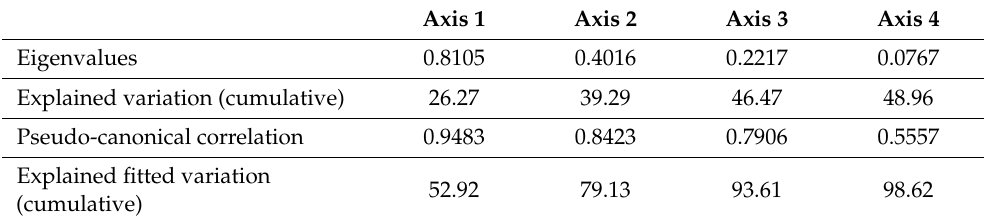
Figure 8. CCA of the physicochemical factors of the studied sites ( a ) and taxa ( b ) . (The red arrows show the distribution of environmental factors in the ordination space) Table 2. Eigenvalues, variations and correlation of the CCA. Table 2. Eigenvalues, variations and correlation of the CCA.